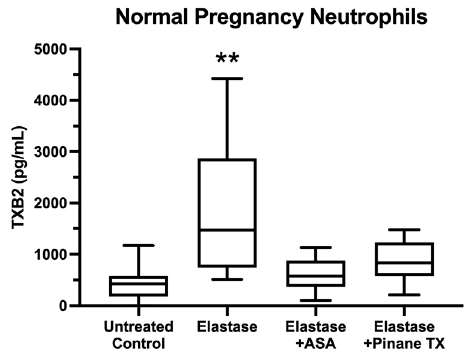
Figure 3. Media concentrations of TXB2. ( n = 11, ** p < 0.01; ASA, aspirin).